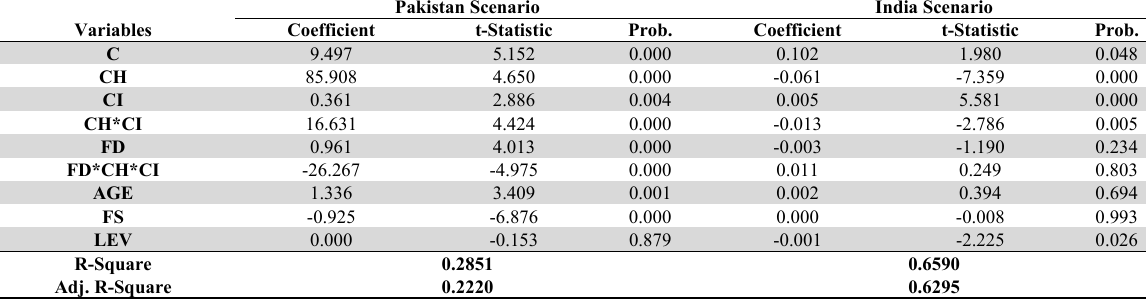
Generalized Method of Moments (Fixed Effect